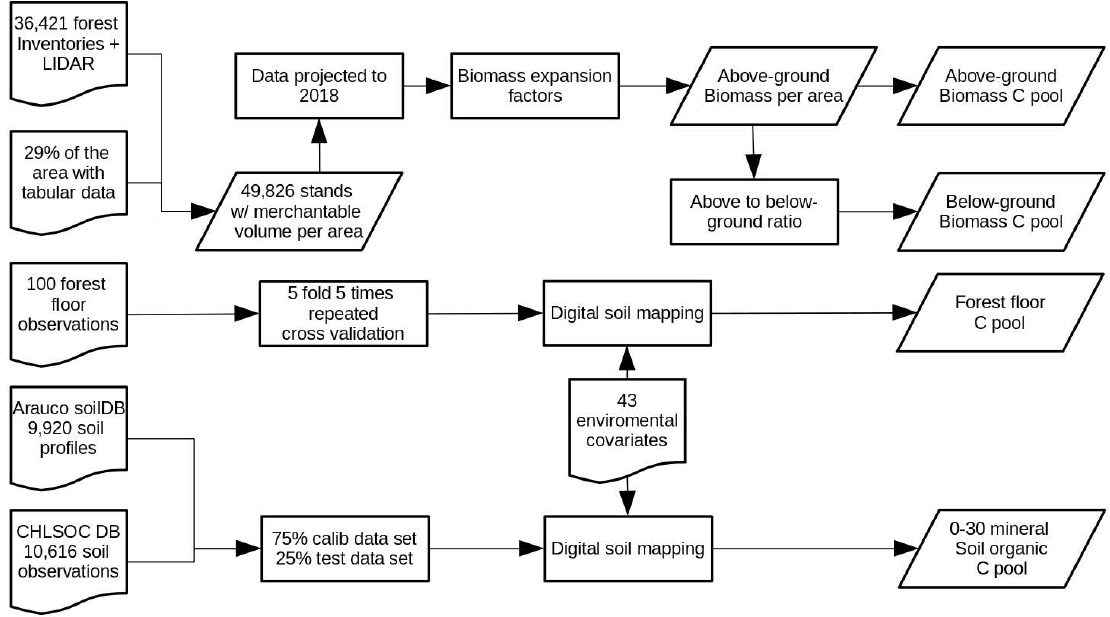
Figure 1. Flow diagram describing the input data and the modeling process used to estimate the 4 carbon pools using a data-driven